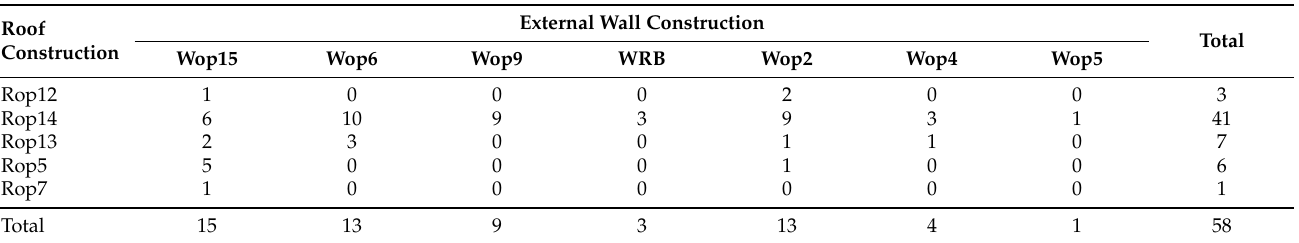
Figure 7. Optimization analysis result at Pareto’s front for the OB operating in AC mode. Table 8. Resulting counts of each layout combination that appeared at Pareto’s front for the Office